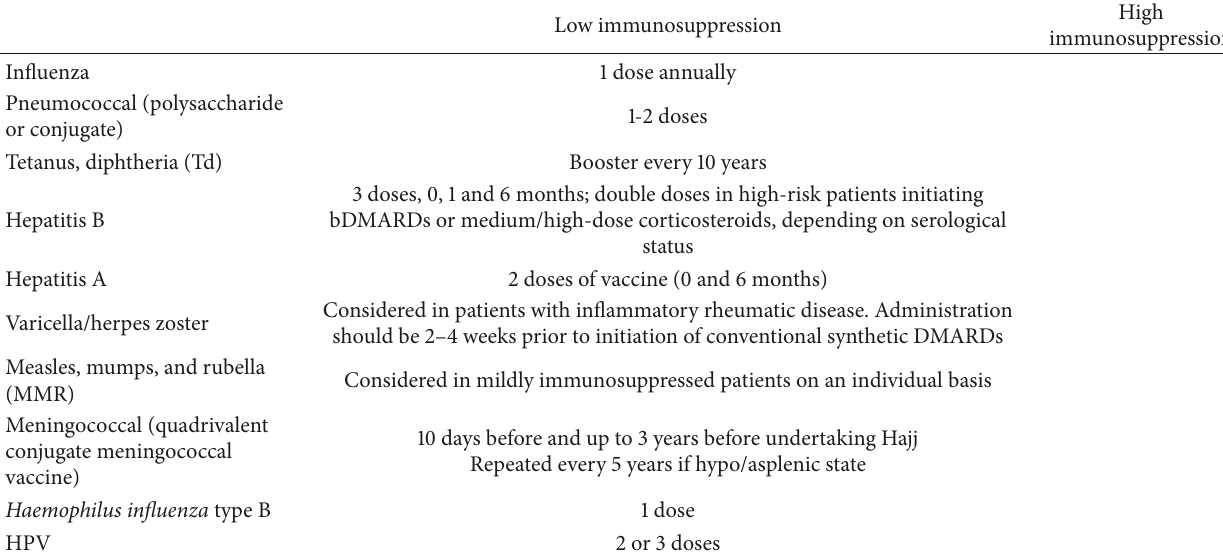
Table reproduced with permission from the European Journal of